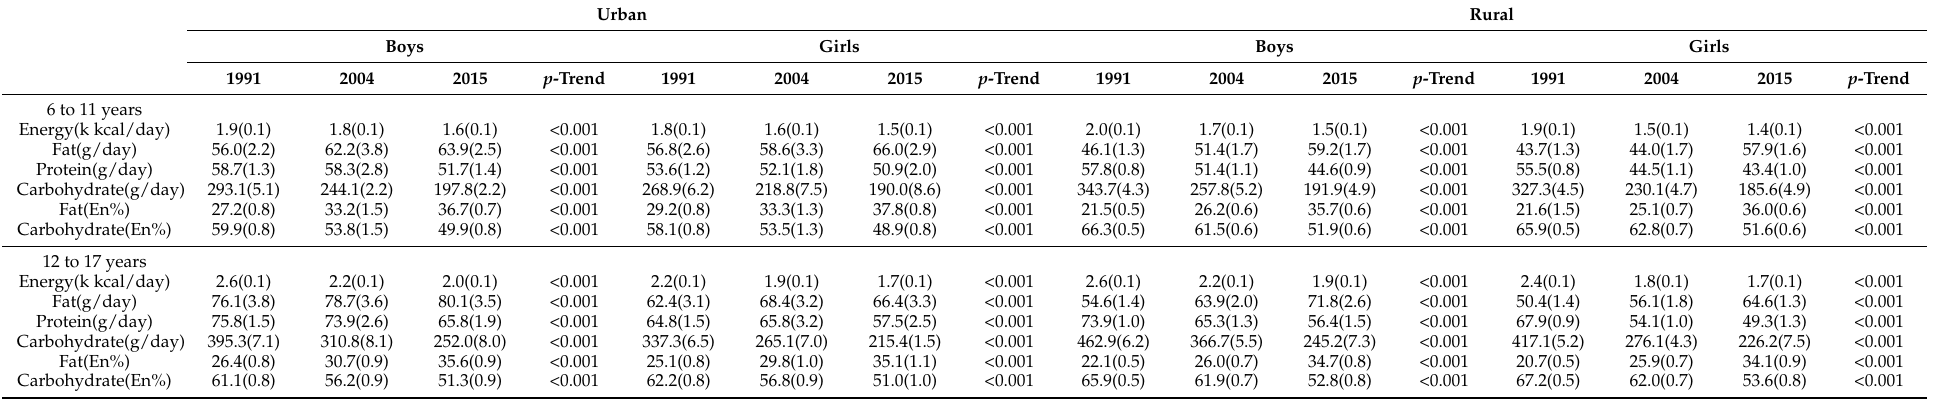
Table 3. Trends in the daily energy and macronutrient composition by region, gender and age group from CHNS round, 1991–2015 1–4 . Urban Rural Boys Girls